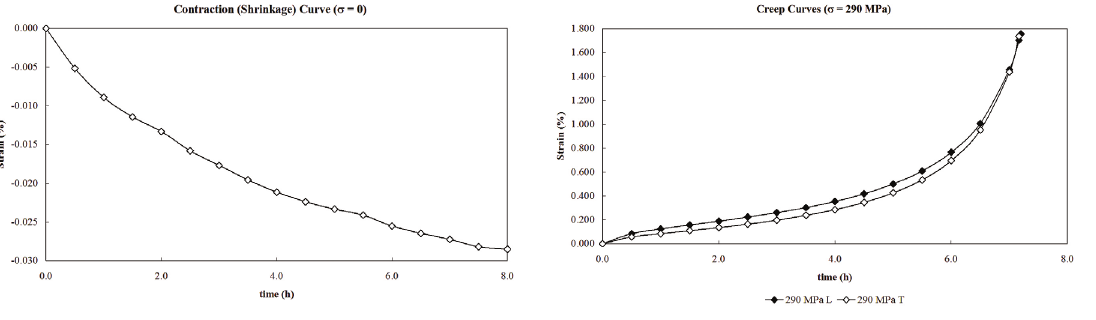
Figure 15. Contraction (shrinkage) curve for AA7050-TAF (creep test σ =0).